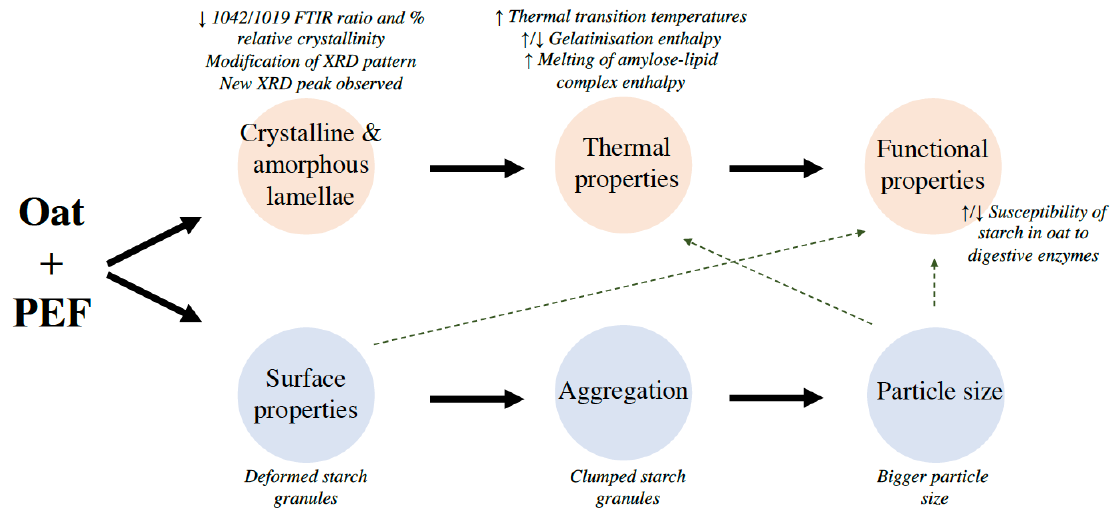
Figure 7. Possible mechanism of PEF treatment impact on oat flour properties. The symbols “ ↑ ” and “ ↓ ” denote increase and decrease of specific properties, respectively.